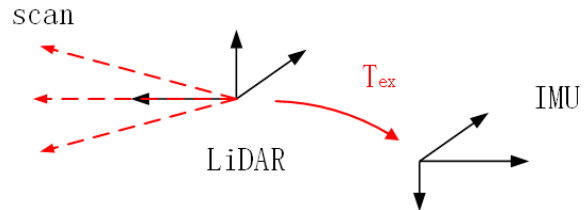
Figure 8. T ex is the pose of inertial measurement unit (IMU) in the LiDAR frame, known from prior calibration.